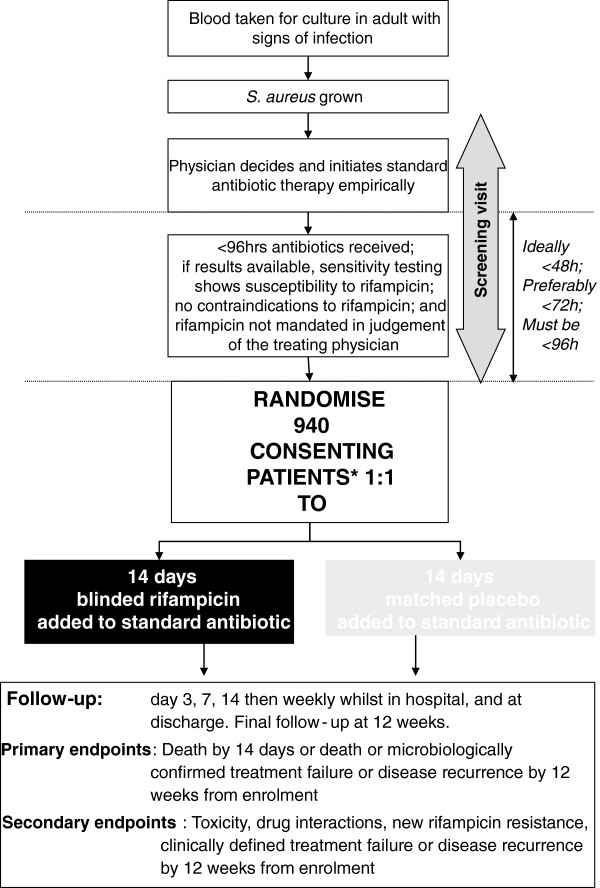
Flow of participants through the trial.